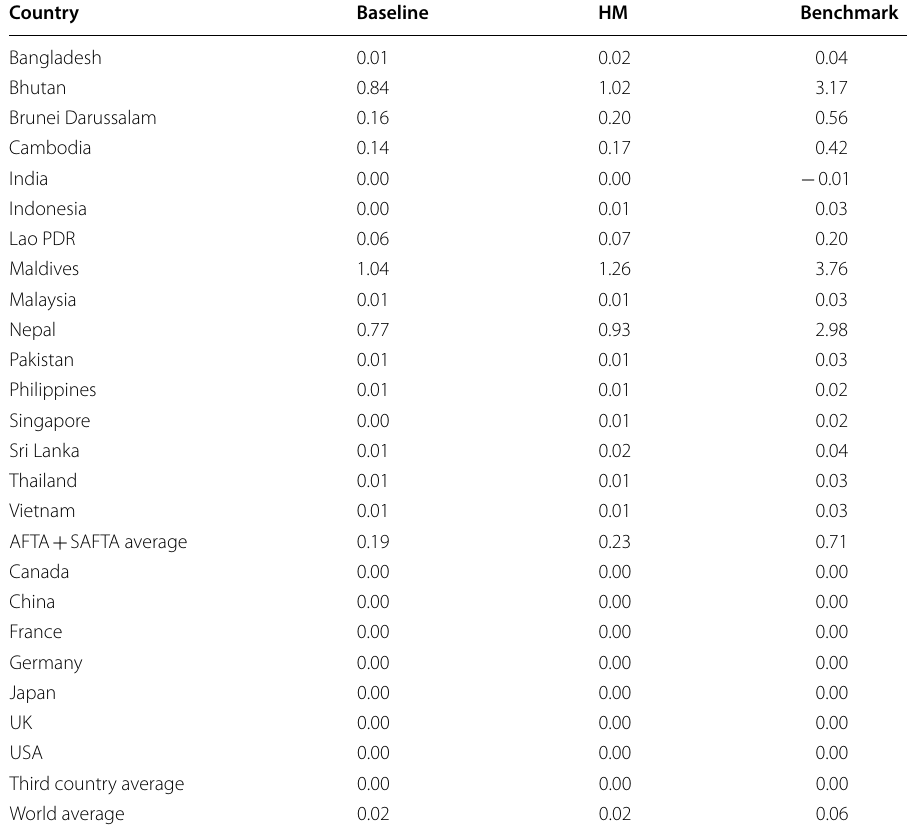
Table 8 Full GE effect of SAFTA Authors’